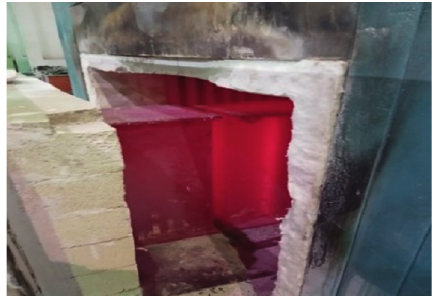
Figure 6: Cooling process of the specimen.